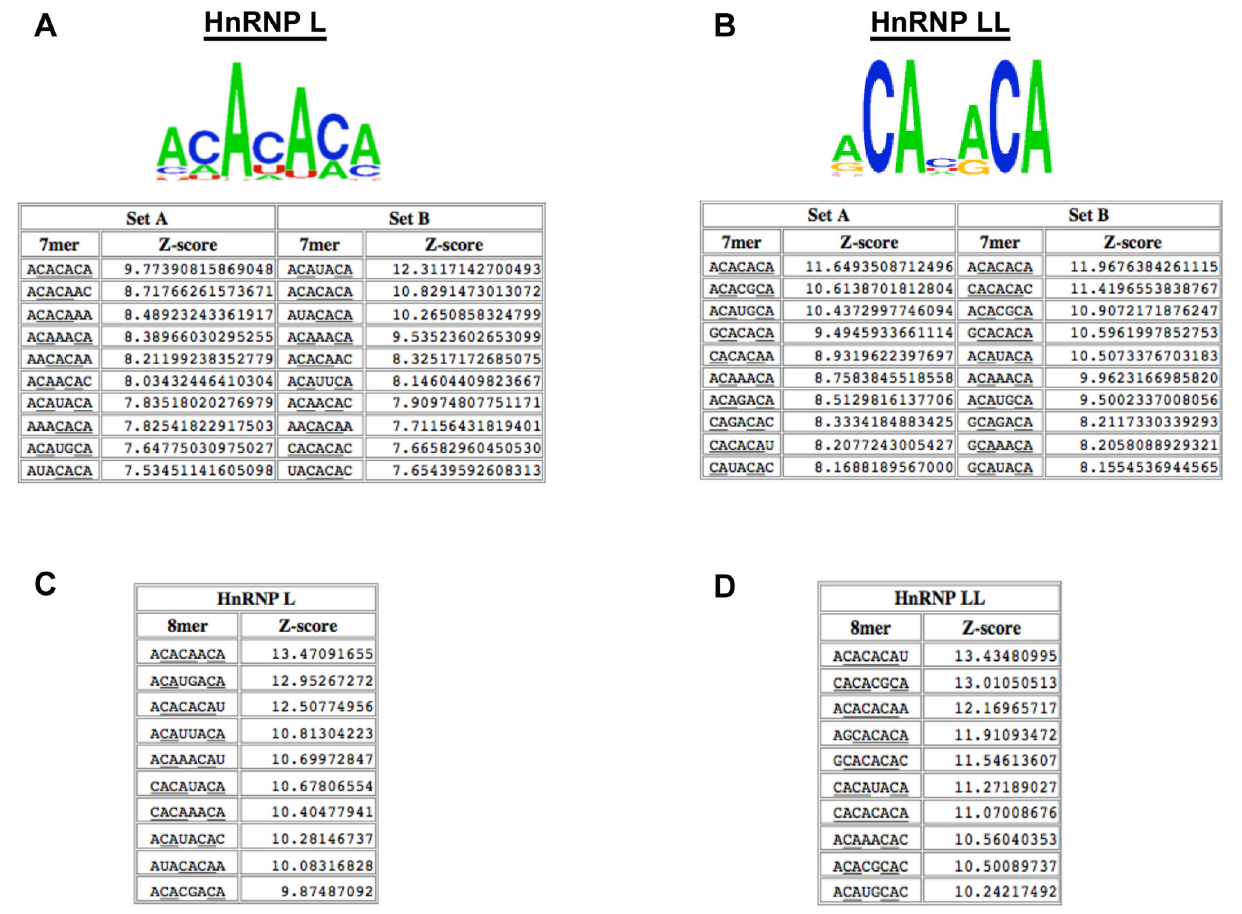
Figure 2. RNAcompete identifies overlapping but distinct k-mers as preferentially bound by hnRNP L and LL. (A) Top, position frequency matrix for the top ten heptamers in the total data set. Bottom, the ten heptamers (7-mers) with highest enrichment value (Z-score; numbers to right of sequences) in RNAcompete probe sets A and B with GST-hnRNP L. Z-score values were calculated as described previously [3]. CA dinucleotides are underlined. (B) Same as in panel A but with hnRNP LL. (C) The top ten octamers (8-mers) with highest enrichment value (Z-score; numbers to right of sequences) in the total RNAcompete data with GST-hnRNP L or (D) with hnRNP